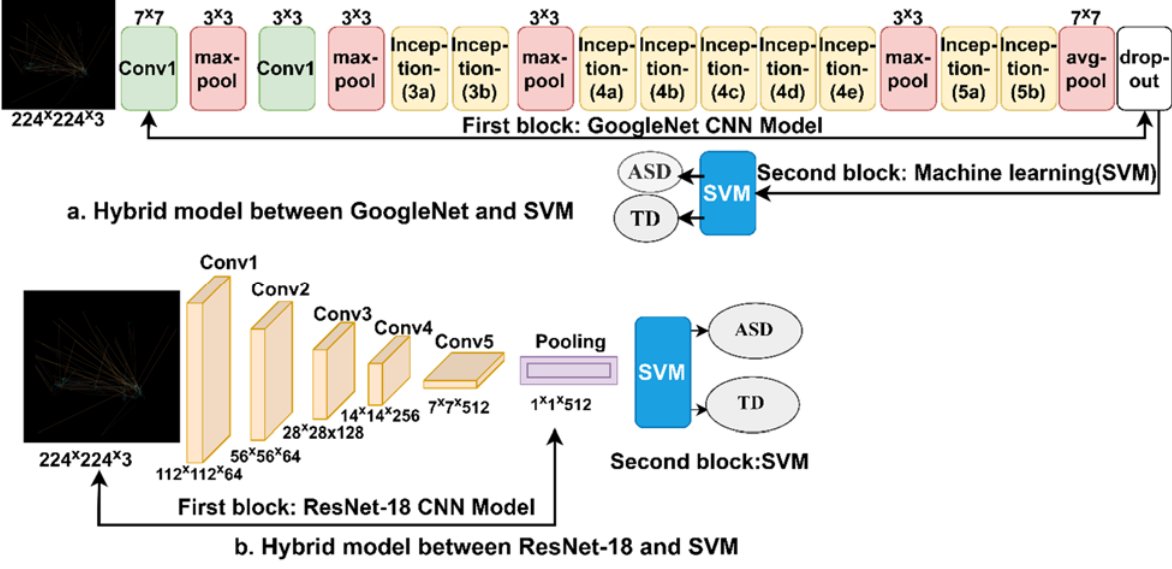
Figure 9. Hybrid technique between deep learning and machine learning. ( a ) GoogleNet + SVM and ( b ) ResNet ‐ 18 + SVM.